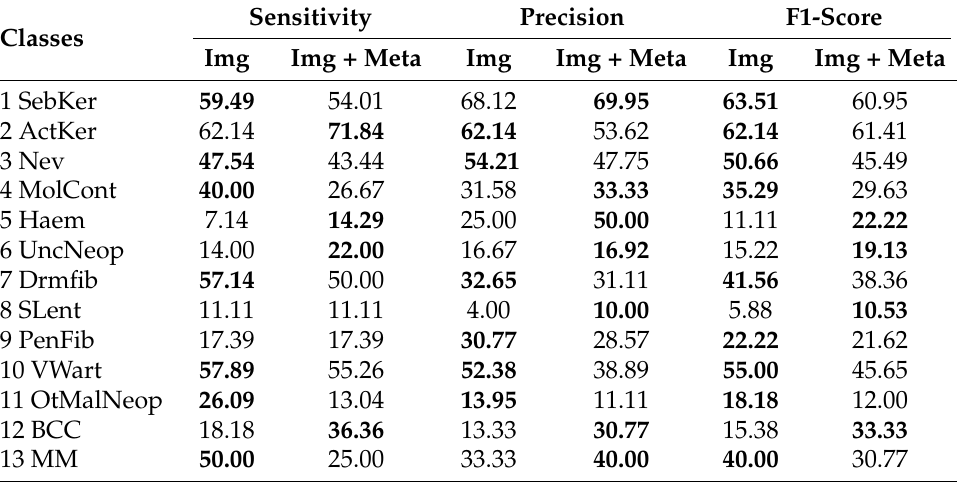
Table 6. Resulting metrics of test set 1 for the differential diagnosis model trained with curriculum learning (in %), considering images (img), or images and metadata (img + meta) as the